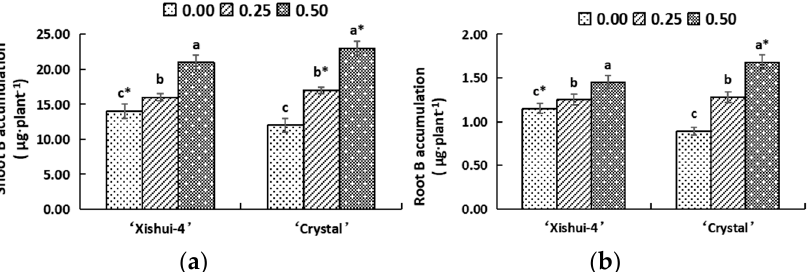
Figure 3. Effects of B-deficiency on B accumulation ( μ g·plant − 1 ) of two grape genotypes: ( a ) shoot; ( b ) root. Different lowercase letters within each column are significantly different at p < 0.05 between treatments. * is significantly different at p < 0.05 between genotypes.